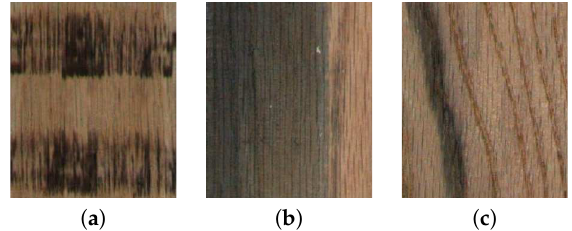
Figure 4. The irrelevant color information on the surface of wooden boards. ( a ) Indentation. ( b ) Lubricating oil. ( c ) Natural